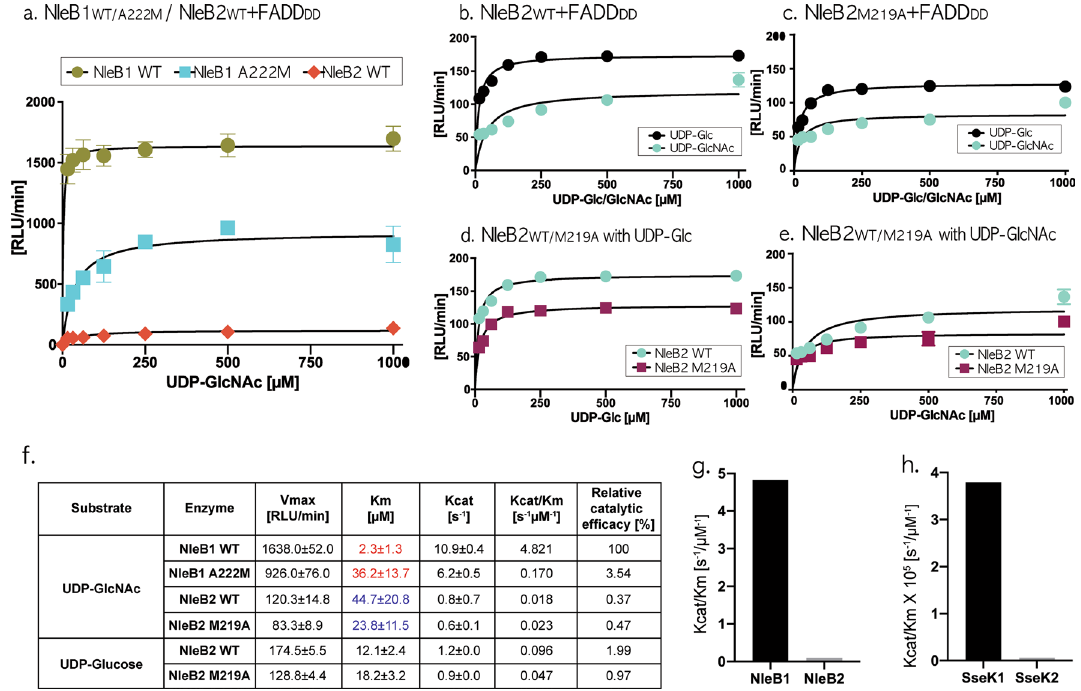
Figure 6. Kinetic analysis of NleB1/2 and their derivatives with FADD DD in the presence of UDP-Glc/ GlcNAc. ( a – e ) Graphical representation of the Michaelis–Menten kinetics for NleB1, NleB2, and their variants, measured using a UDP-Glo assay. Each protein construct was purified by Ni-NTA and gel- filtration chromatography. The UDP-GloTM Glycosyltransferase assay (Promega) was performed as per the manufacturer’s instructions. The mean relative light units (RLU) detected from three replicates are shown with error bars representing the standard deviation. ( f ) Vmax, Km, and Kcat values are calculated using non-linear regression of the Michaelis–Menten equation in GraphPad Prism 8, shown with the standard deviation. ( g , h ) Bar chart showing the relatively weaker glycosyltransferase activity of NleB2 and SseK2 than that of NleB1 and SseK1, respectively; the data for SseK1/2 glycosyltransferase activity was obtained from Park et al. 2